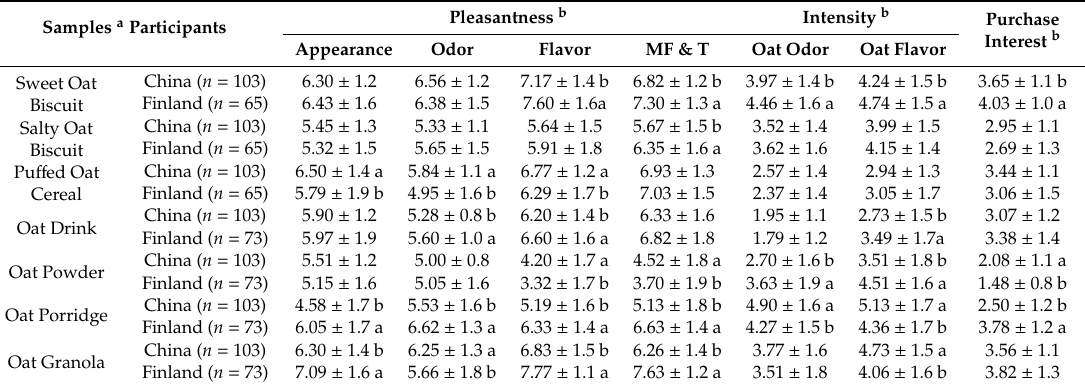
Table 4. Comparison of the rated pleasantness, intensities oat odor and flavor and interest to purchase for the oat